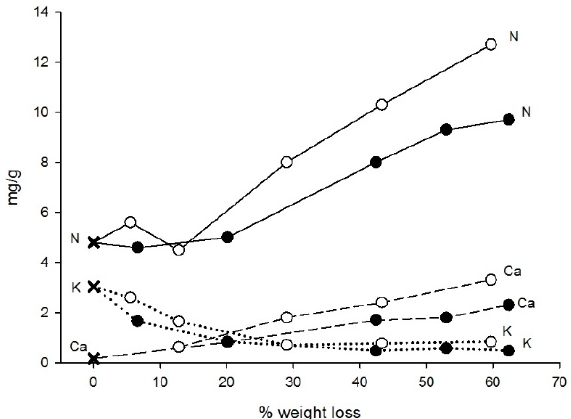
Figure 6. Changes in the concentration of nitrogen (solid lines), calcium (stippled lines) and potassium (dotted lines) during decomposition of cones. Filled circles: moss habitat. Open circles: needle mat habitat.